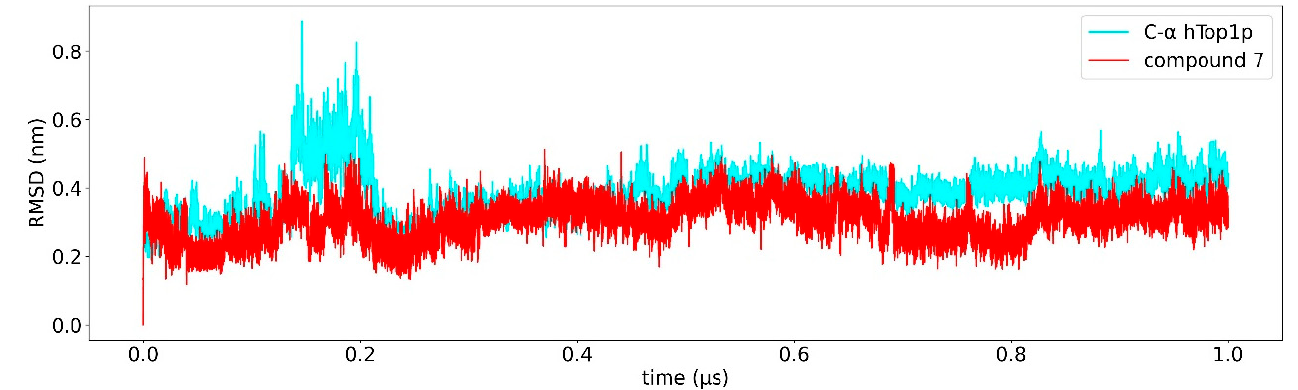
Figure 4. Root mean square deviation (RMSD) relative to 1 us of simulation. The RMSD of C α of the protein is shown in cyan, the RMSD of compound c7 is shown red.